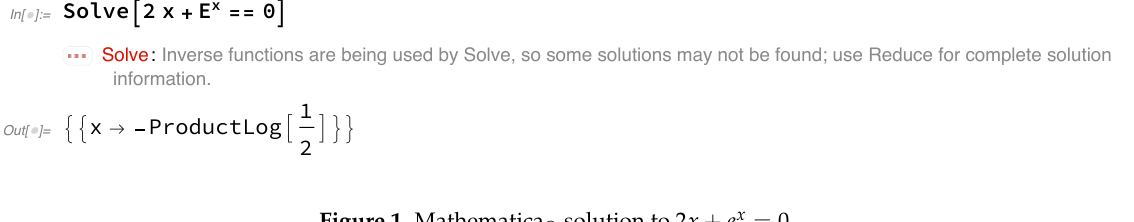
Figure 1. Mathematica ® solution to 2 x + e x = 0.